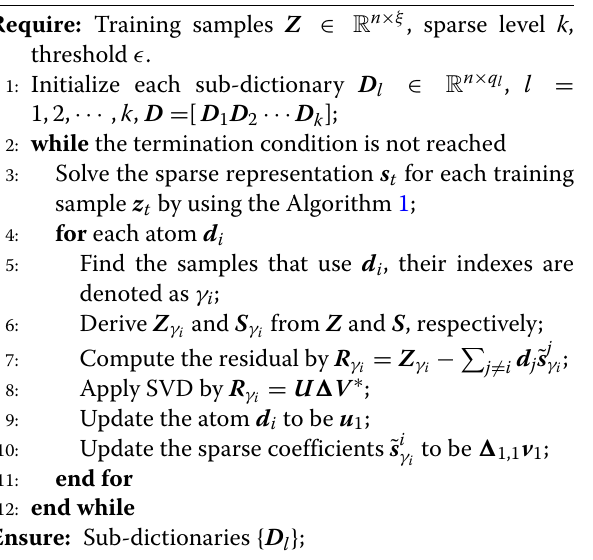
Algorithm 2 CK-SVD for DL